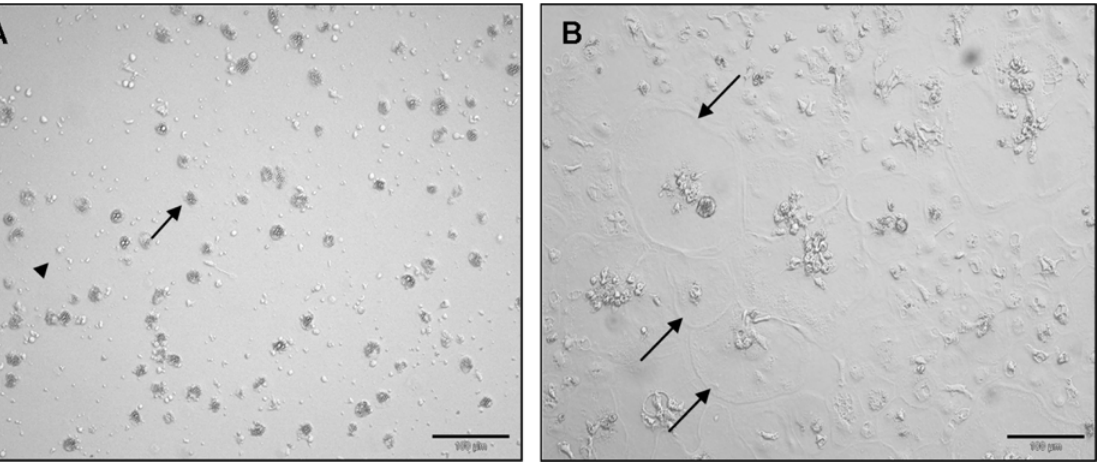
Fig 1. Phase contrast micrographs of primary avian macrophages. A) Heterogeneous cell population at day 1 after isolation. B) Day 7 of primary cell culture, monocytes differentiated into flattened circular macrophages with extensive cytoplasmic veil. arrowhead: lymphocyte, arrow: primary macrophage, bar = 100 μ